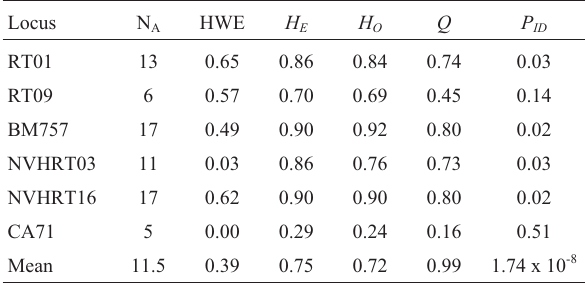
Table 2 - Characterization of six microsatellite loci transferred to Ozotoceros bezoarticus leucogaster based on the genotyping of 50 indi- viduals in a population from the Brazilian Pantanal.